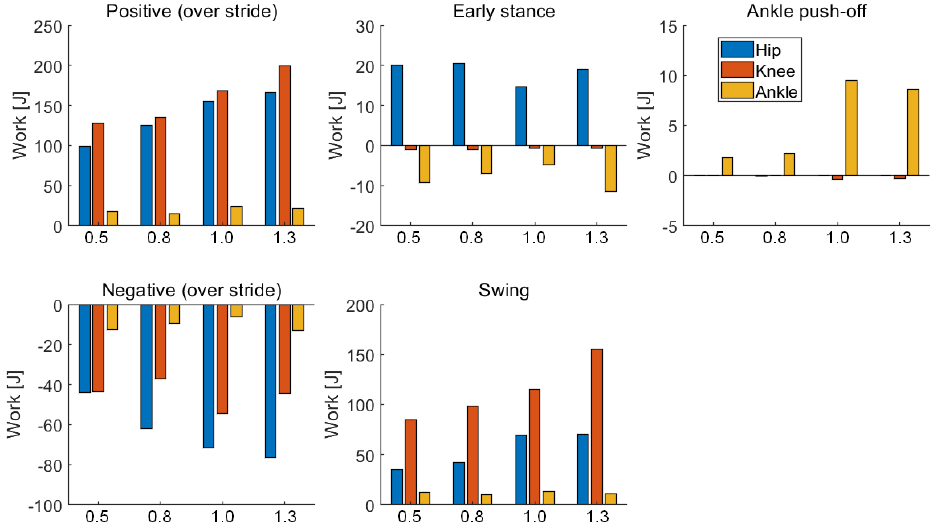
Figure 12. Mechanical work of the joints at different walking speeds. Positive and negative work during the gait cycle, including the early stance, ankle push-off, and swing phase.